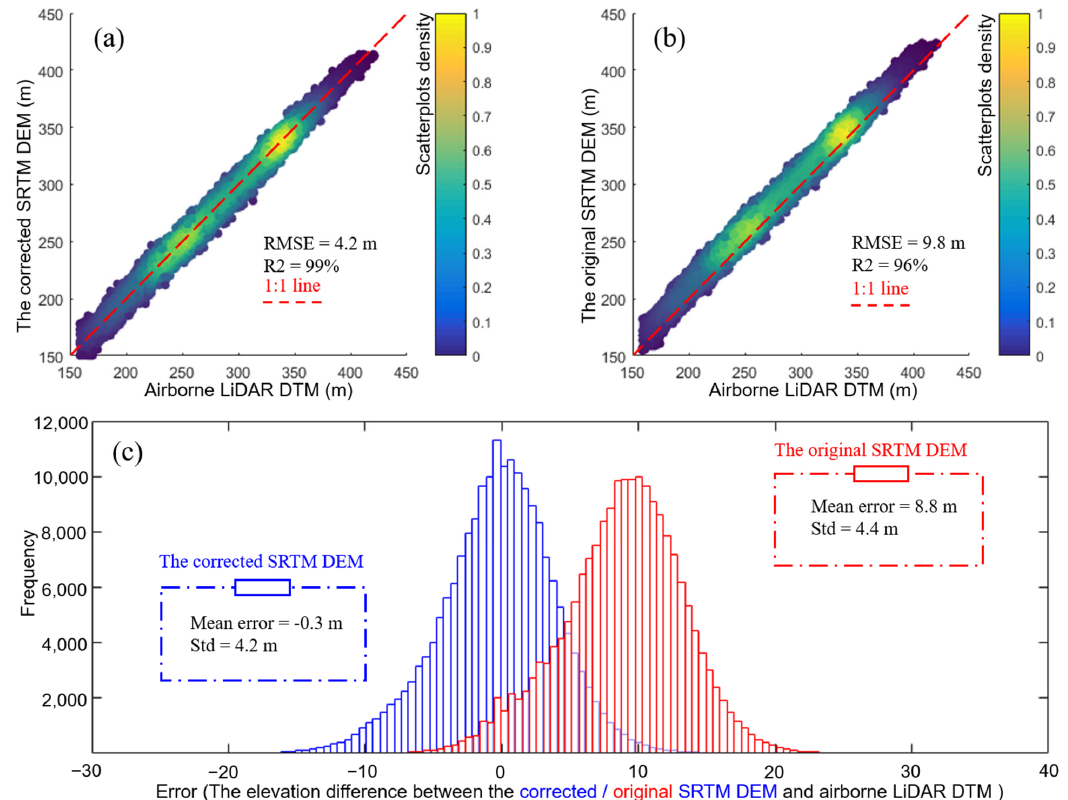
Figure 4. Scatterplots of ( a ) the corrected SRTM DEM and ( b ) original SRTM DEM versus the reference LiDAR DTM; ( c ) histogram of errors between the corrected SRTM DEM/original SRTM DEM and the reference LiDAR DTM.